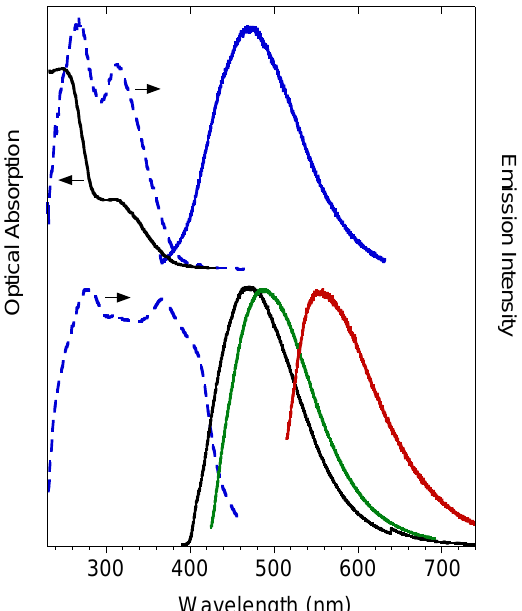
Figure 13. Normalized absorption and emission spectra of poly-6-MOEG-9-T- BF3k -FE in dichloromethane solution (top) and in the solid state (bottom). Optical absorption (black solid line), emission excitation profiles (λ em = 470 nm, dotted blue lines) and emission spectra (λ ex = 330 nm, blue solid line; λ ex = 390 nm, black solid line; λ ex = 420 nm, green solid line; λ ex = 490 nm, red solid line).